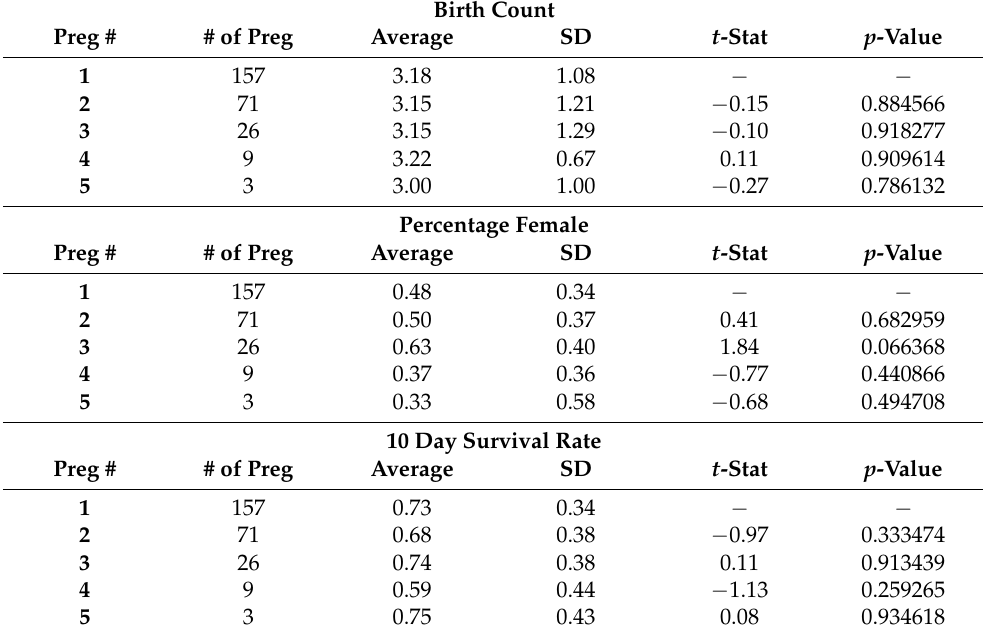
Table 6. The impact of the number of pregnancies of strain 13/N guinea pig sows on total fetus count, percentage of females in a litter, and survival rate after 10 days, as compared to first